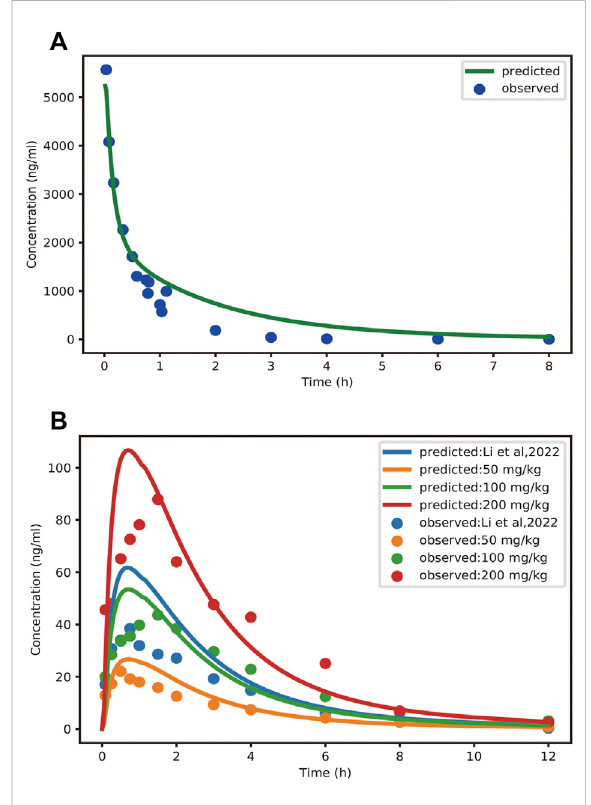
FIGURE 3 Observed and PBPK-model-predicted plasma concentration-time pro fi les of schaftoside after intravenous injection of schaftoside solution (A) and oral administration of TFDS suspension (B) . Solid circles represent observed mean data,andsolidlinesrepresentthepro fi lespredictedfromthePBPK model in PK-Sim. Doses were 1.2 mg/kg (iv) and 50, 100, 200 mg/kg (po), respectively. Additionally, the dose of TFDS in the previous report (Li et al., 2022) is 100 mg/kg.